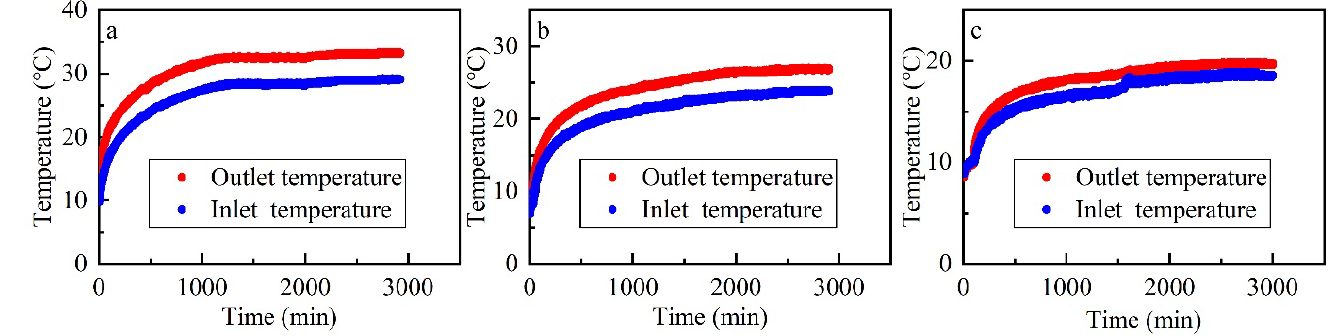
Figure 5. Inlet and outlet time temperature curves. ( a ) Condition A. ( b ) Condition B. ( c ) Condition C.